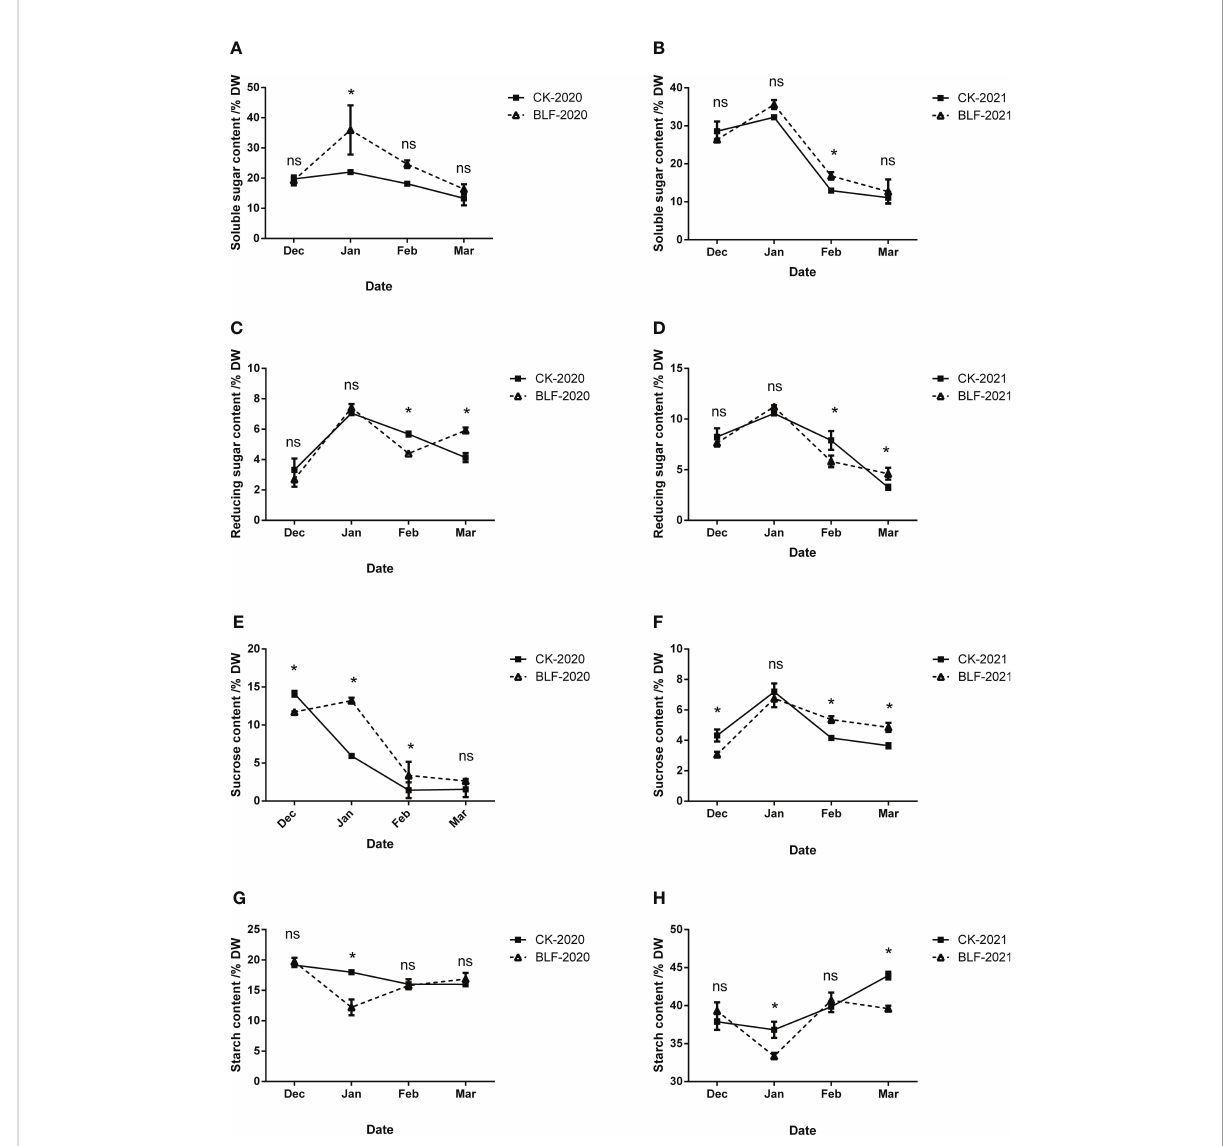
FIGURE 7 Effect of spraying BLF on the content of soluble sugar (A, B) , reducing sugar (C, D) , sucrose (E, F) and starch (G, H) on 2020 and 2021. “ * ” means that the average value of each parameter is signi fi cant between the two treatments (p<0.05), and ns means no signi fi cance by Duncan ’ s multiple range